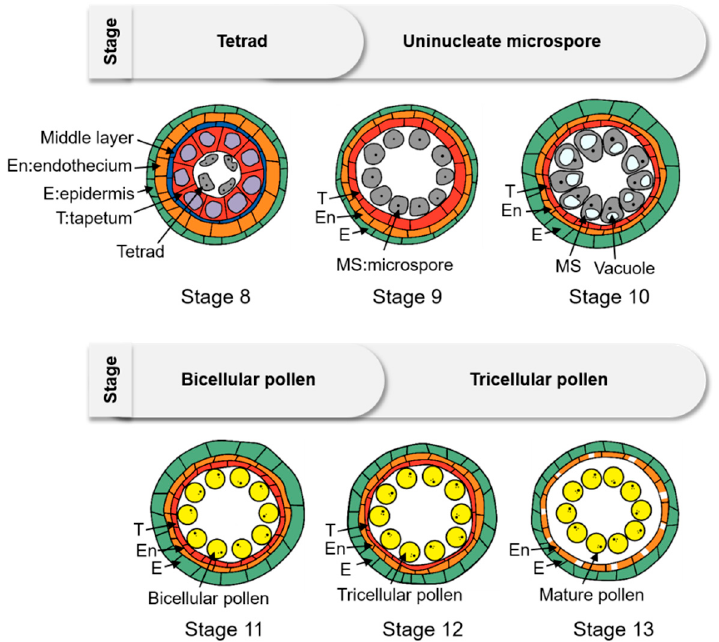
Figure 1. Diagrams of the late stage of rice pollen development. The number of each stage follows the description in Zhang et al. [3].